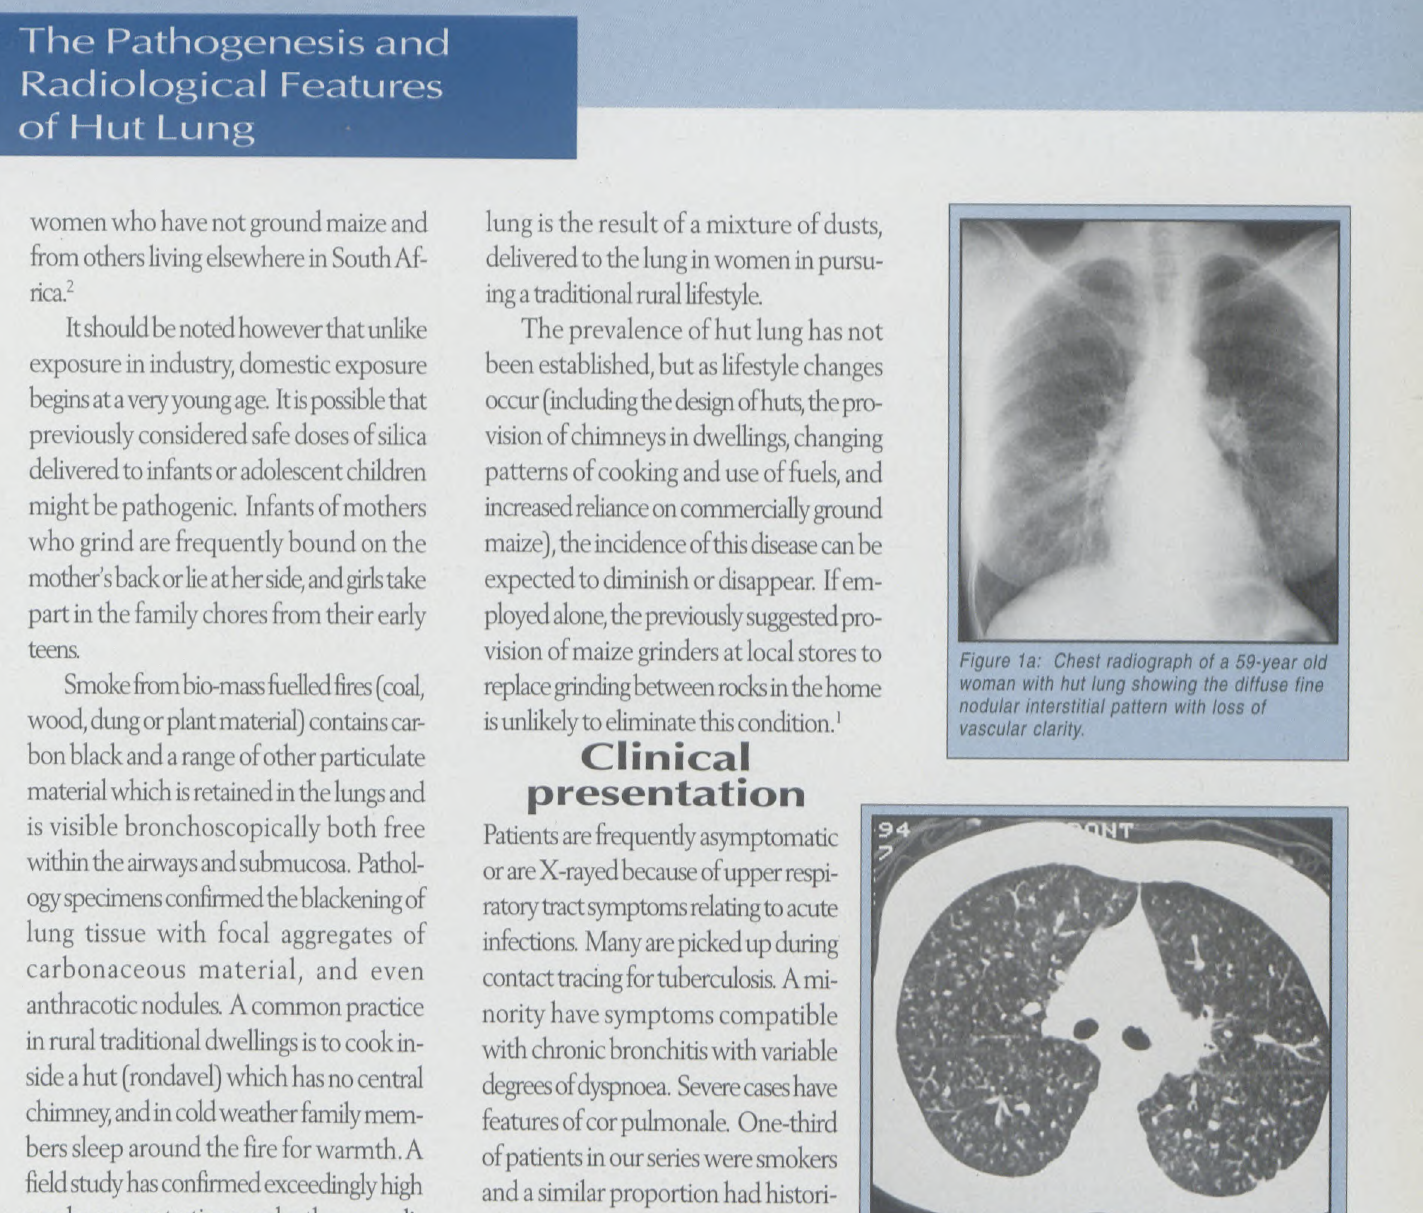
Figure tb: HRCT lung views of the patient shown in la confirming the presence of evenly distributed centri/obular nodules in profusion. Fissures are nol thickened and bronchovascular markings are